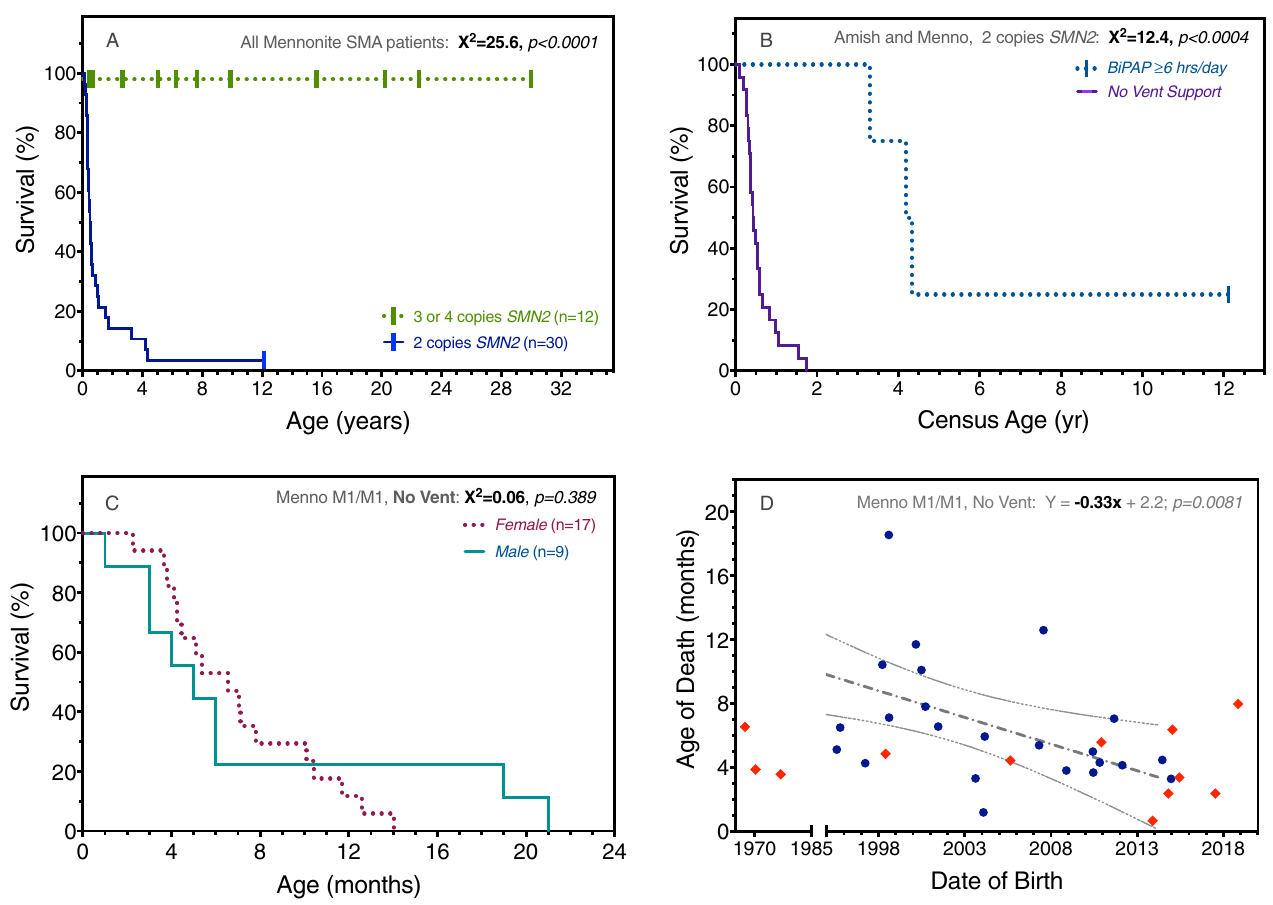
Fig 6. Survival in relation to SMN2 copy number, ventilatory support, sex, and birth date. (A) All SMA patients with 3 or 4 copies of SMN2 (green) are presently living, whereas 29 (97%) of 30 with 2 SMN2 copies (blue) died at a median age of 6.2 months. (B) Among a total of 44 patients with 2 copies of SMN2 (M1/M1, n = 30; A1/A1, n = 14), bilevel positive airway pressure (BiPAP) for (cid:21) 6 hours daily (n = 5) increased median survival from 5.3 to 51 months (p < 0.0004). (C) When controlled for BiPAP use and genotype (e.g. M1/M1, no BiPAP, as depicted in Panel C), there was no survival difference based on sex. (D) Paradoxically, date of birth and age of death were inversely correlated for Mennonites with the M1/M1 genotype (Pearson r = -0.51, p = 0.0081).